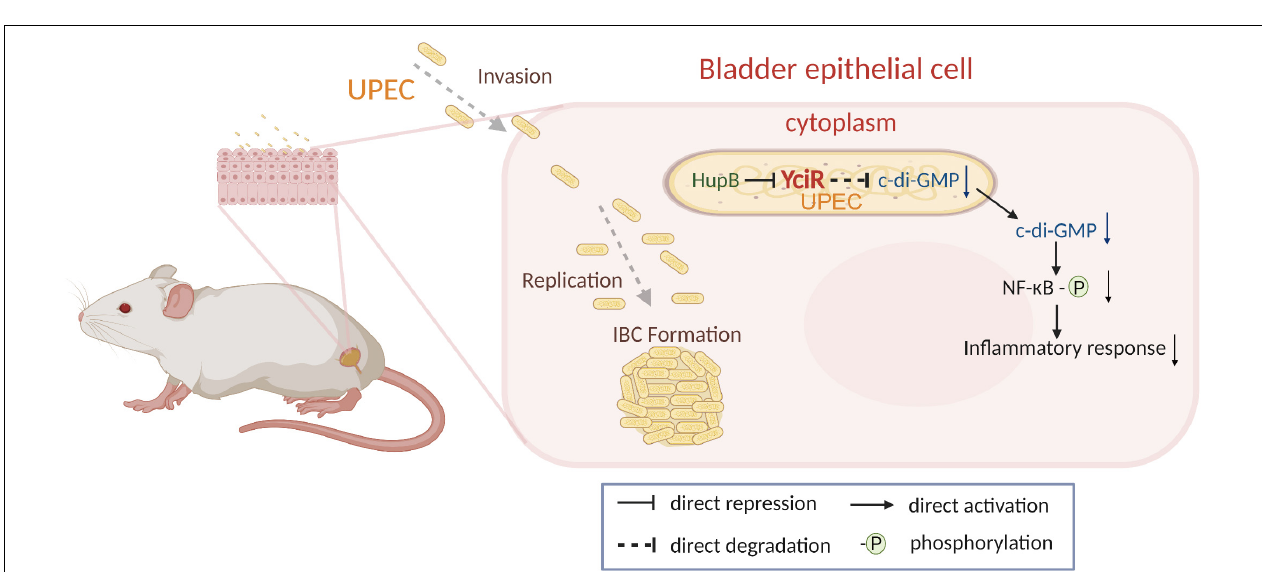
FIGURE 8 | HupB directly binds to the yciR promotor. (A) EMSAs of the yciR promotor with the purified HupB protein. (B) lacZ fragment was used as the negative control.